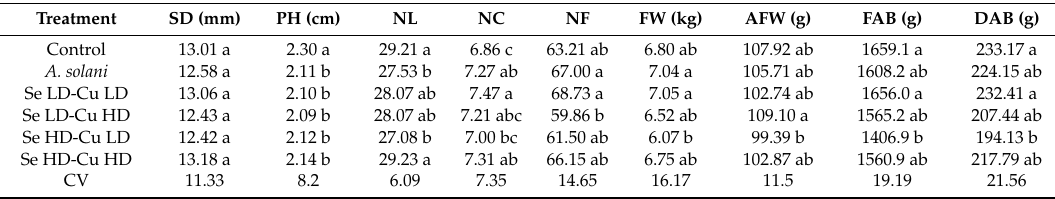
Table 1. Growth variables of tomato